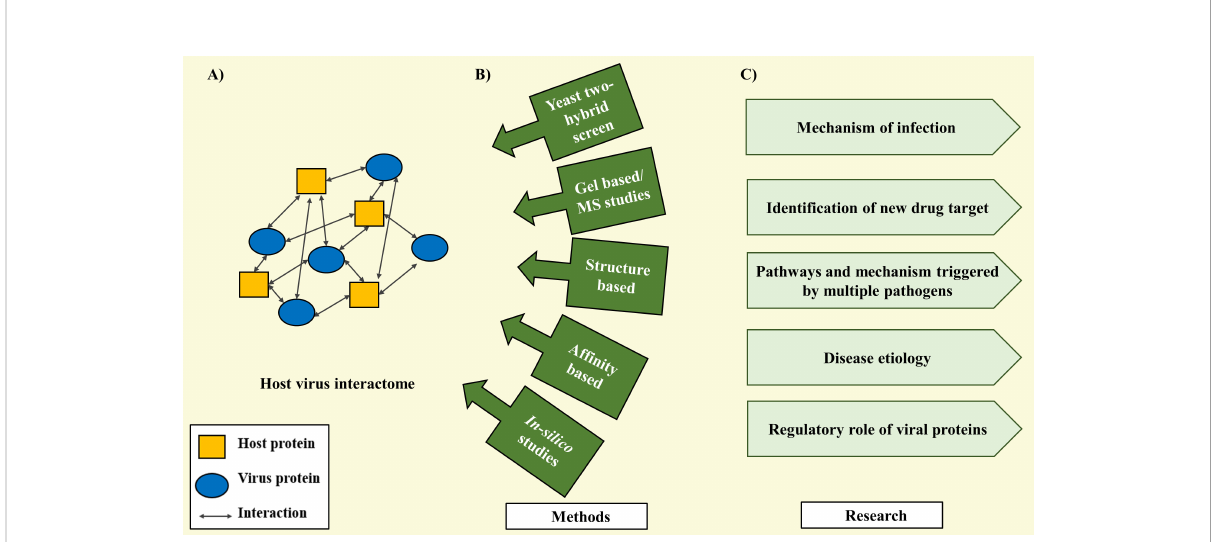
FIGURE 2 Methods to study host-virus interactome. (A) Host-virus interactome showing protein-protein interaction. (B) Different methods to study host- virus interactions. (C) Relevant information gained from studying host-virus